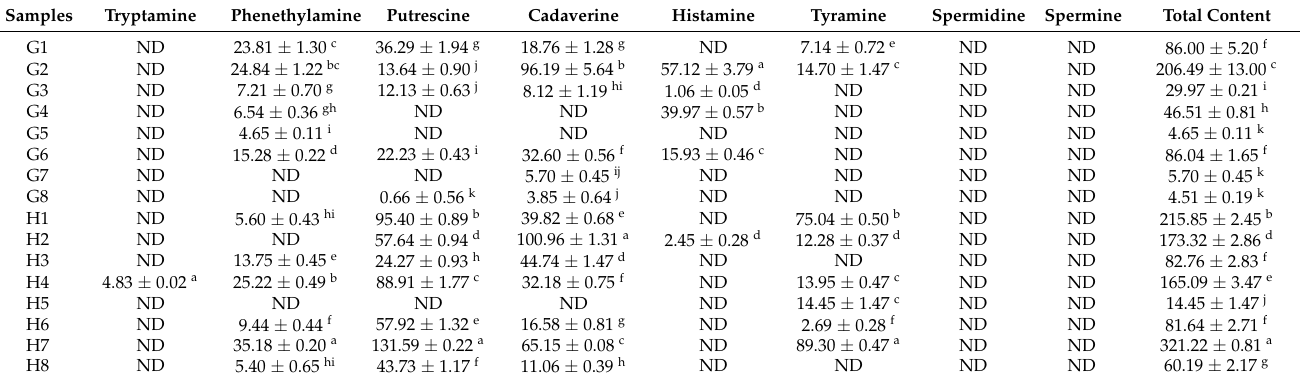
Table 3. Contents of BAs in Suanyu samples (mg/kg fresh weight).